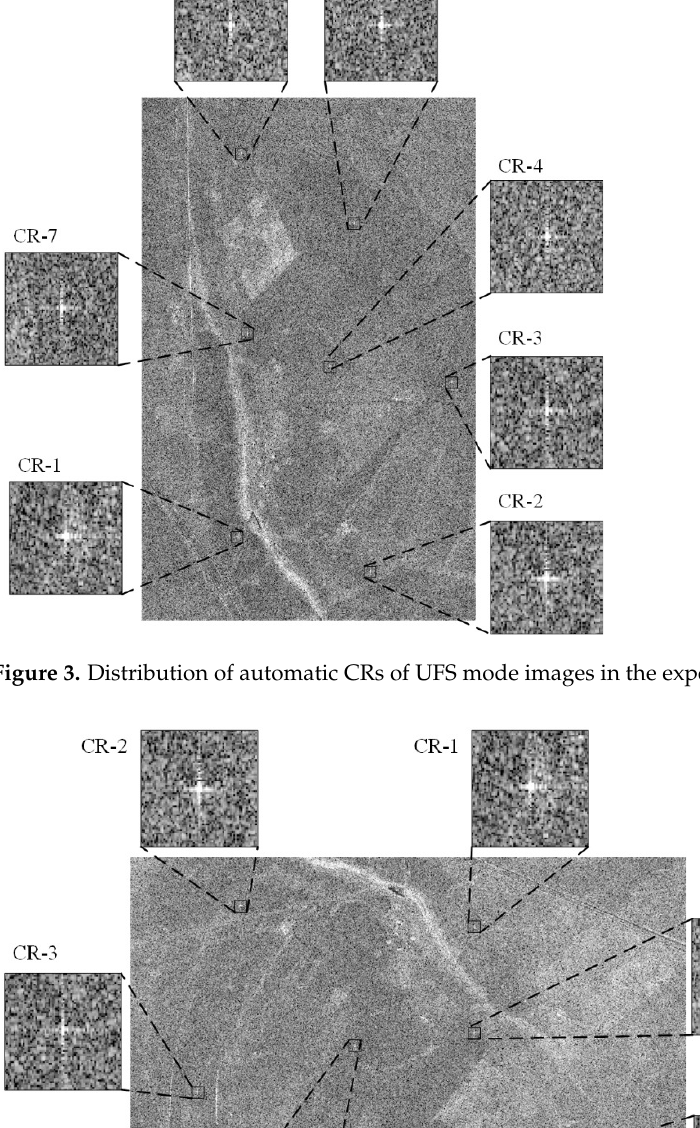
Figure 2. Flexible automatic trihedral corner reflector.